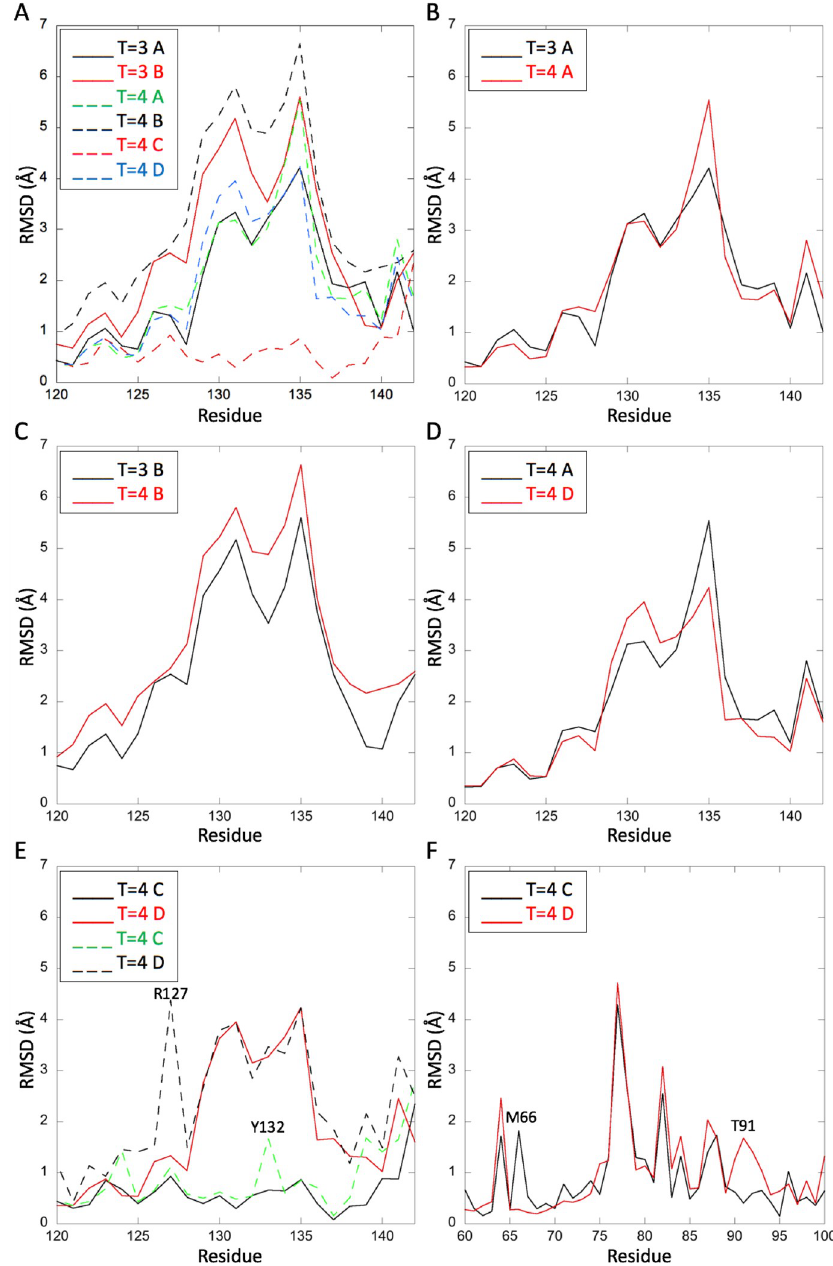
Fig 3. RMSD plots of the six other chains in T = 3 and T = 4 capsids aligned to the T = 3 C chain. (A) C α -RMSD plots for all six chains, between residues 120–142, showing that the C chains are similar to each other and distinct from the others. (B-D) C α -RMSD plots for the chain pairs indicated in the legends, between residues 120–142, showing their mutual similarity. (E) C α (solid line) and all-atom (dashed line) RMSD plots for the T = 4 C and D chains, between residues 120–142, showing differences at residues R127 in the T = 4 D chain and Y132 in the T = 4 C chain. (F) All-atom RMSD plots for the T = 4 C and D chains, between residues 60 and 100, showing differences at residues M66 in the T = 4 C chain and T91 in the T = 4 D